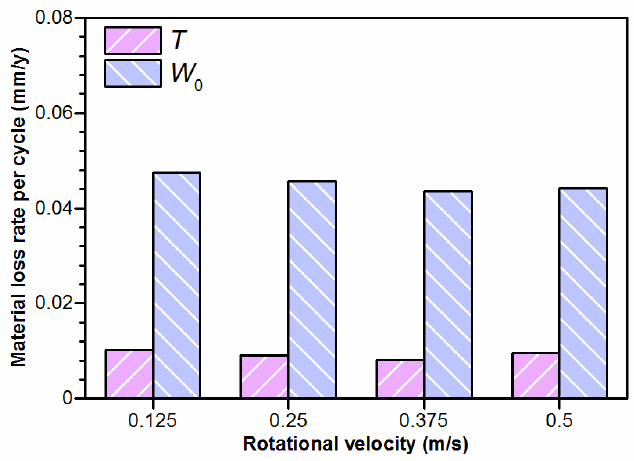
Figure 9. The material loss rate per cycle after tribo-corrosion and mechanical wear at various rota- tional velocities.